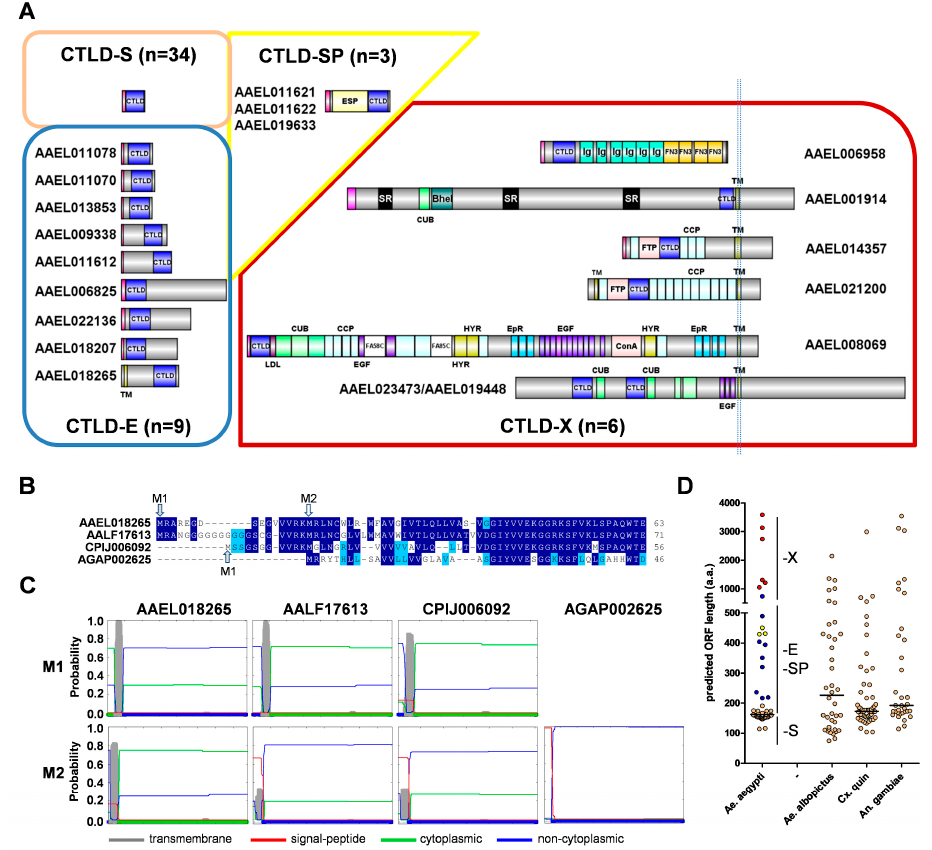
Figure 1. A. aegypti C-type lectin domain containing proteins (CTLDcps). ( A ) Primary structure and categorization of CTLDcps. CTLD-S (orange box), CTLD-E (blue box), CTLD-SP (yellow box), and CTLD-X (red box) are indicated. All of the models were drawn to scale using IBS v1.0.3. Predicted signal peptides are indicated at the N-terminus of each sequence (pink), along with predicted transmembrane spanning domains (TM; gold), CTLD (dark blue), and elastase-serine protease (ESP). For CTLD-X members, domains are as indicated and the reader is directed to supplemental Table S1 for a full list of domains including accession numbers for each; ( B ) Alignment of the N-terminus of CTLD-E gene AAEL018265 and its orthologs from other mosquitoes. Identical (dark blue) and similar (light blue) residues are indicated. Initiation methionine (M1) and alternative methionine (M2) are indicated; ( C ) Signal Peptide/transmembrane domain prediction output from Phobius [14] for CTLD-E gene AAEL018265 and its orthologs based on the M1 or M2 methionines; and, ( D ) Predicted amino acid lengths of CTLD genes in A. aegypti and three other mosquitoes, by category. For A. aegypti , CTLD-S (orange), CTLD-E (blue), CTLD-SP (yellow), and CTLD-X (red) groups are indicated. Horizontal line indicates the median length.